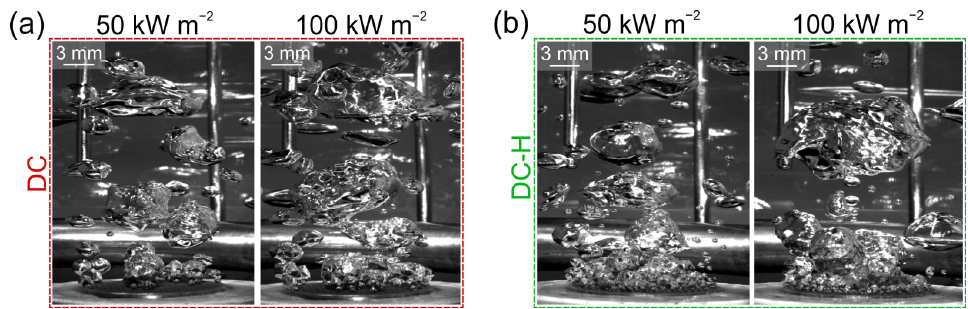
Figure 9. High-speed snapshots of the boiling process at 50 kW m −2 and 100 kW m −2 on ( a ) hydrophilic and ( b ) hydrophobic version of the deep channel surface (DC and DC-H, respectively).